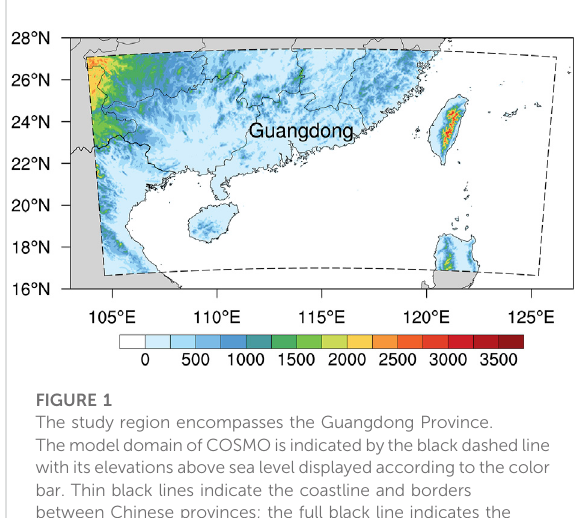
FIGURE 1 The study region encompasses the Guangdong Province. ThemodeldomainofCOSMOisindicatedbytheblackdashedline with its elevations above sea level displayedaccording to the color bar. Thin black lines indicate the coastline and borders between Chinese provinces; the full black line indicates the continental Chinese – Vietnamese